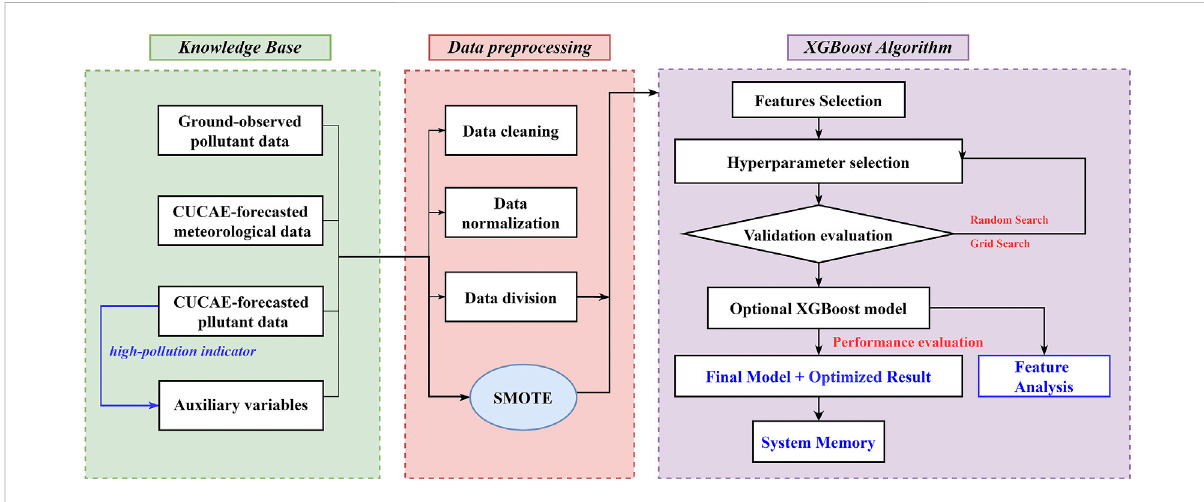
FIGURE 1 The framework of the hybrid XGBoost-SMOTE